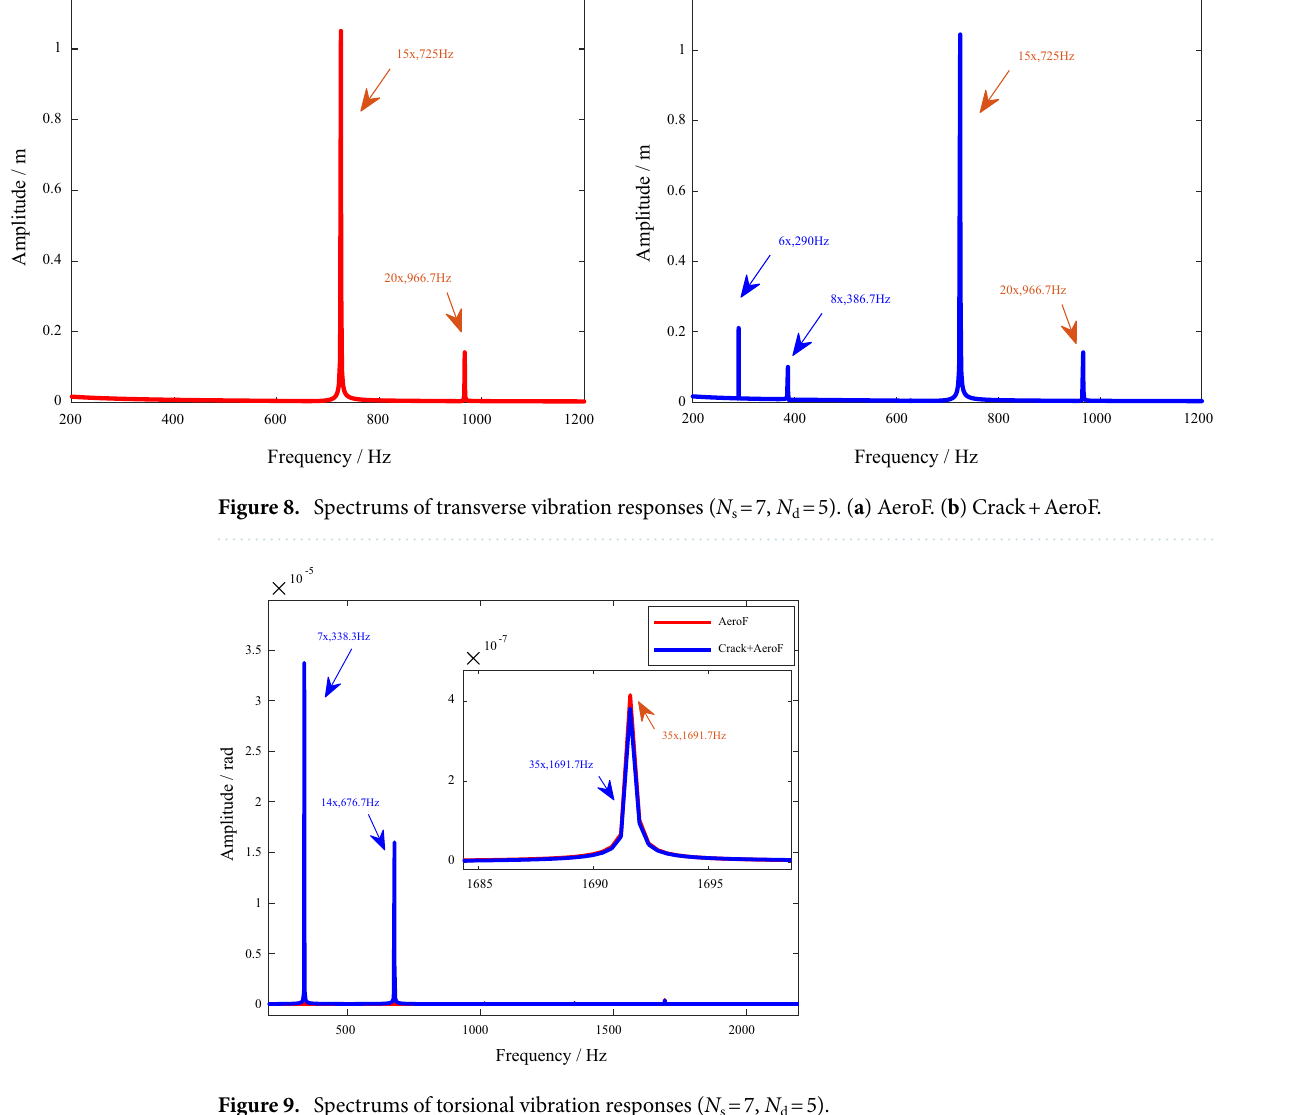
Figure 9. Spectrums of torsional vibration responses ( N s = 7, N d =